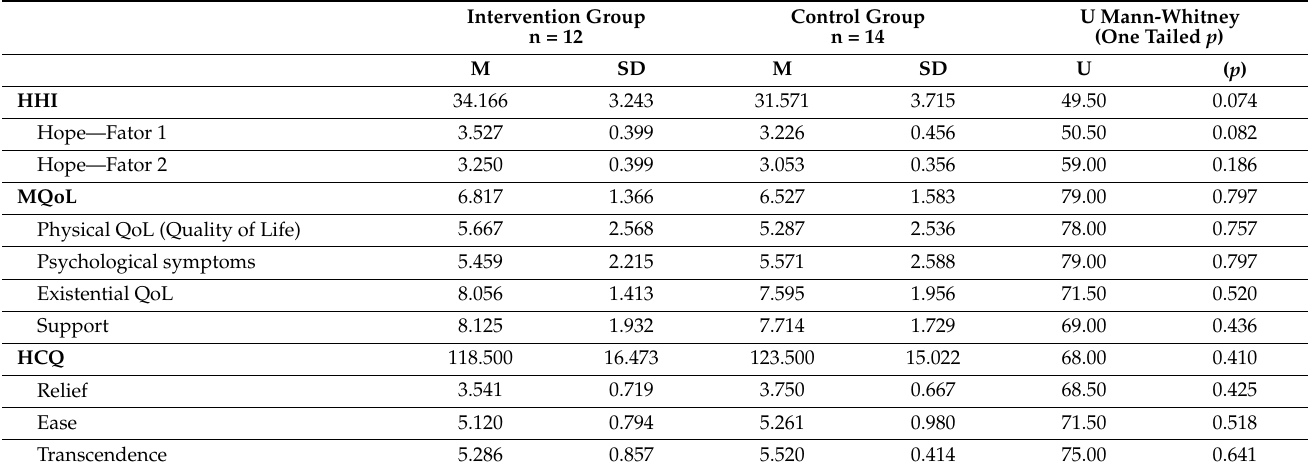
Table 3. Differences in means and results of the Mann-Whitney tests to assess the equivalence between both groups in the variables of hope, comfort and QoL and its dimensions. Intervention Group Control Group n = 12 n = 14